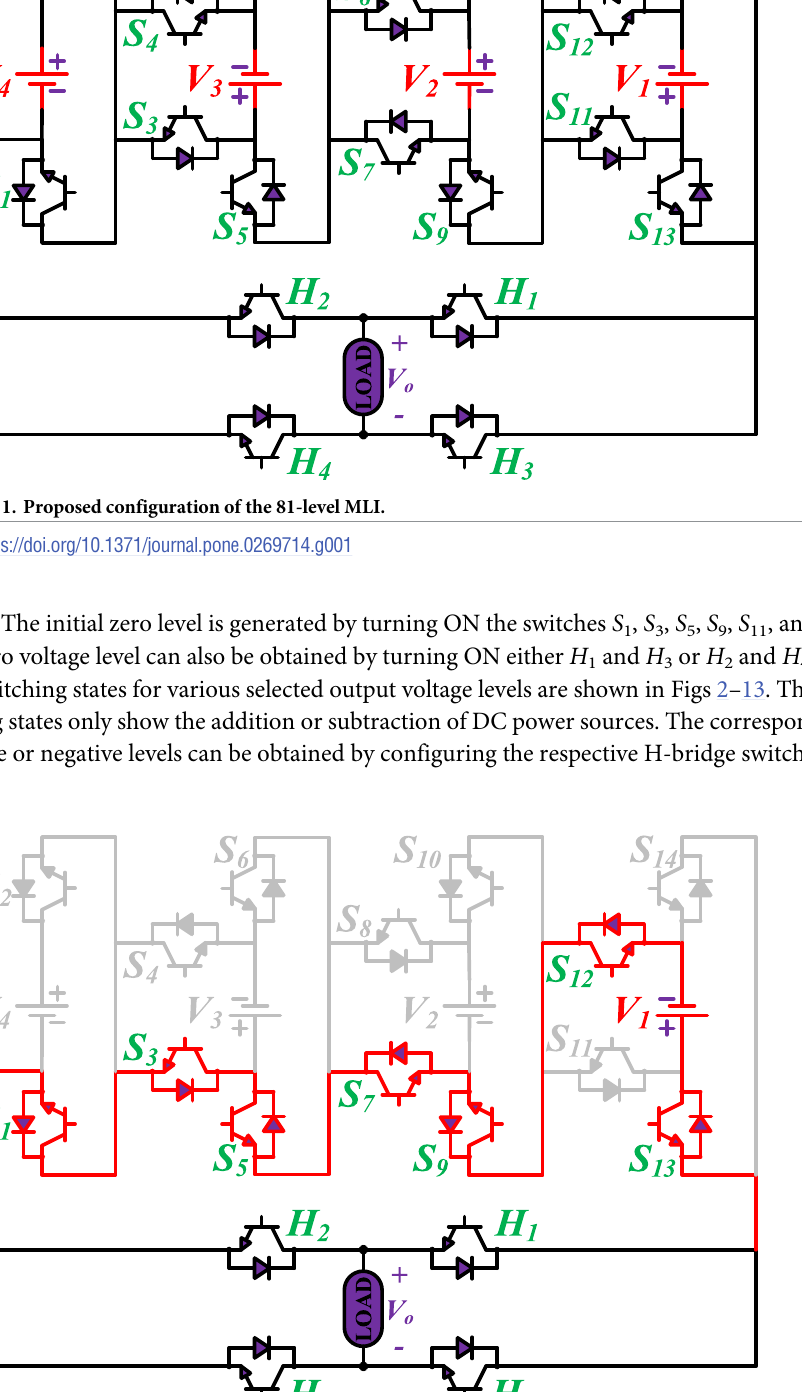
Fig 2. Switching states for voltage magnitude level